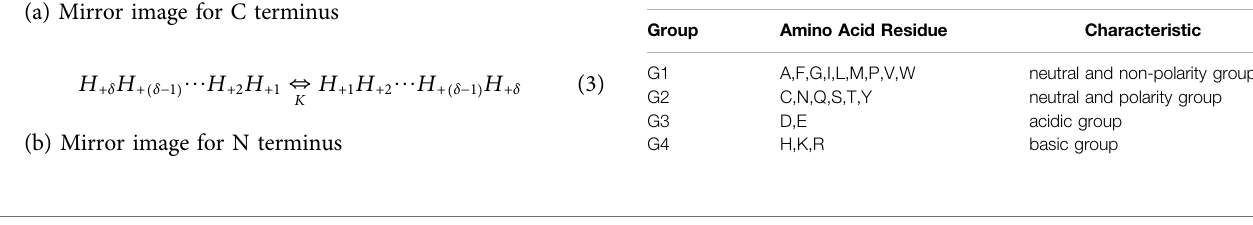
TABLE 1 | Classi fi cation of Amino acid